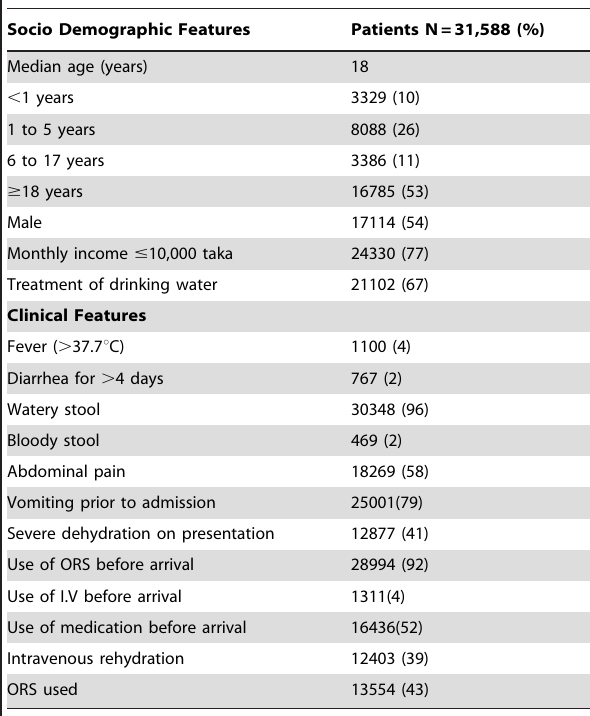
Table 1. Demographic and clinical characteristics of patients from Mirpur between March 2008 and February